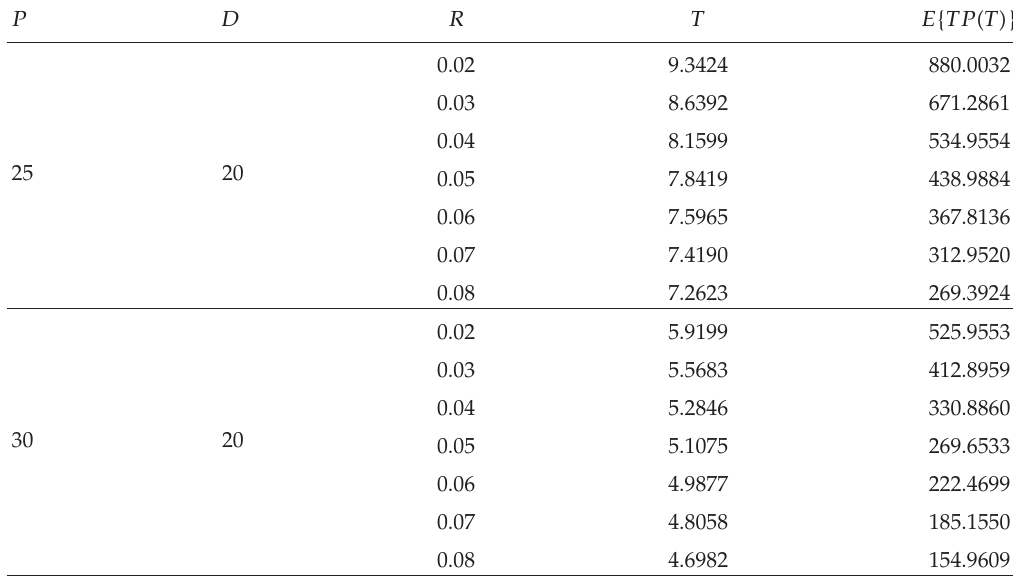
Table 5: Results due to di ff erent R .